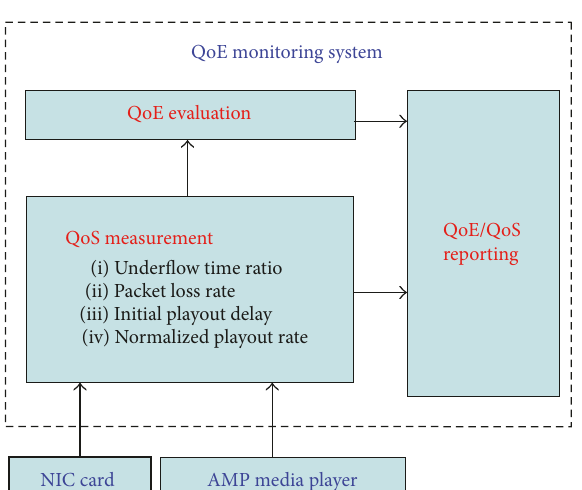
Figure 3: MPEG-2 TS packet format.